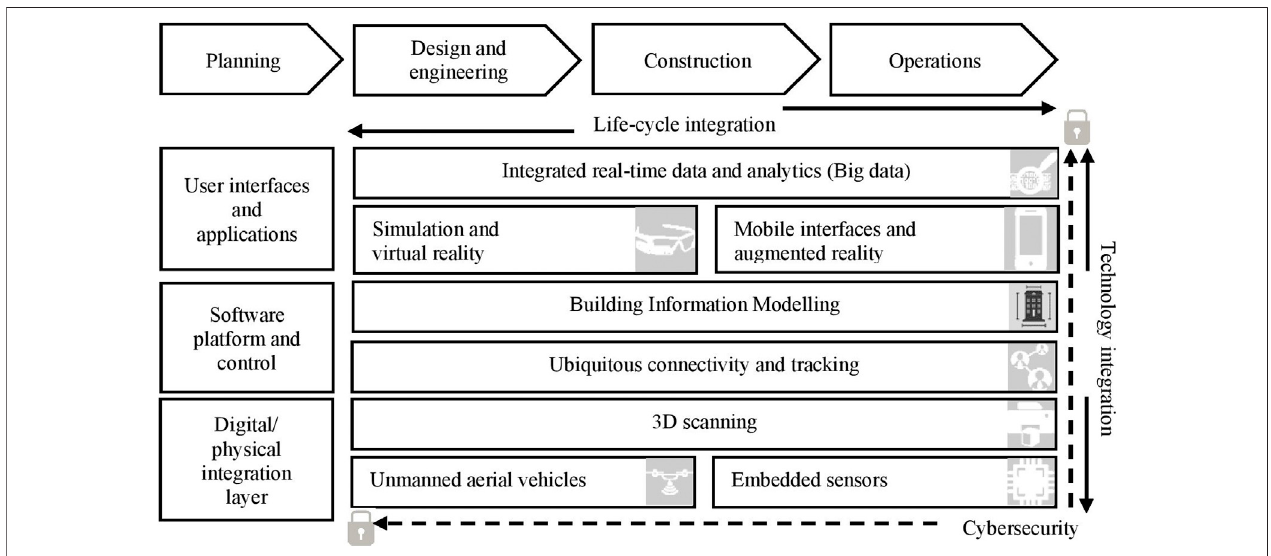
FIGURE 2 | Digital technologies applied in the E&C value chain (Gerbert et al., 2016; Renz et al., 2016; Elagiry et al., 2019).